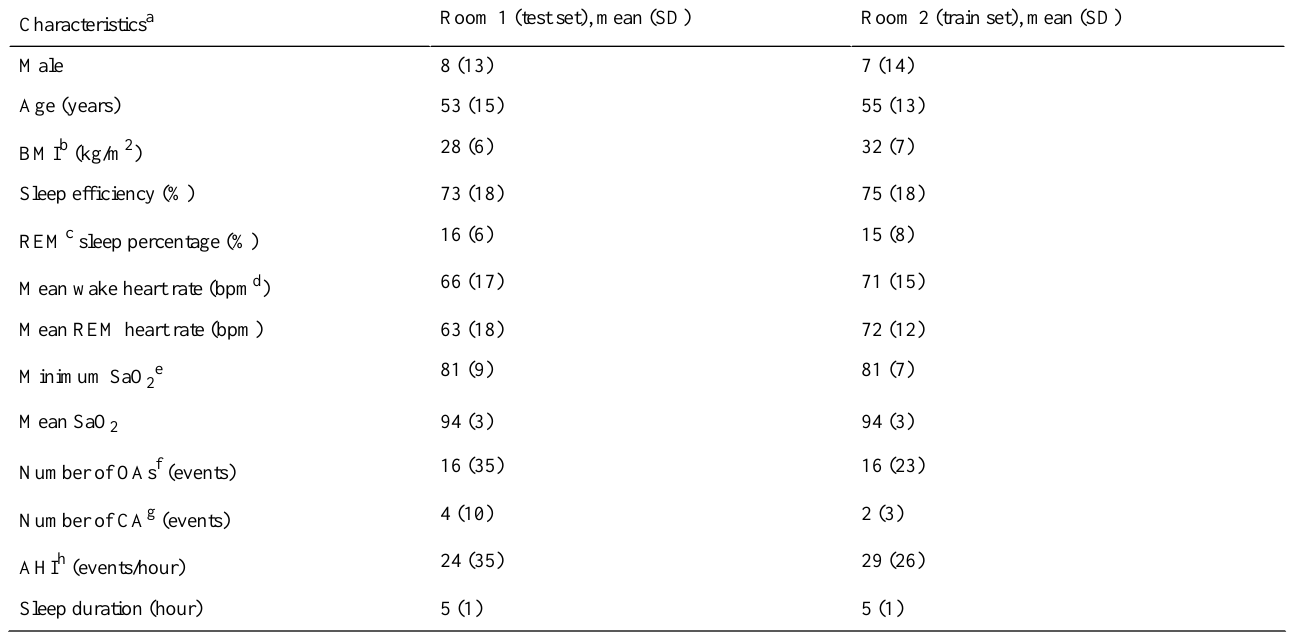
Table 2. Participant demographics (N=42).